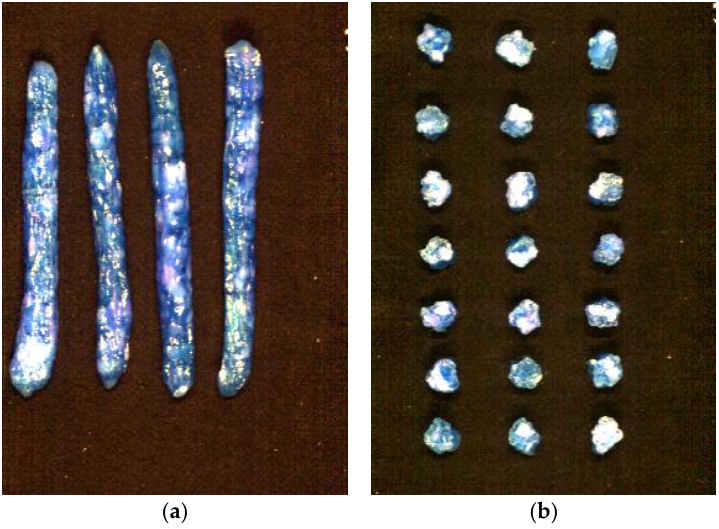
Figure 1. Pseudo images of ( a ) intact and ( b ) sliced sausages (generated from images at 1000, 1200, and 1400 nm).